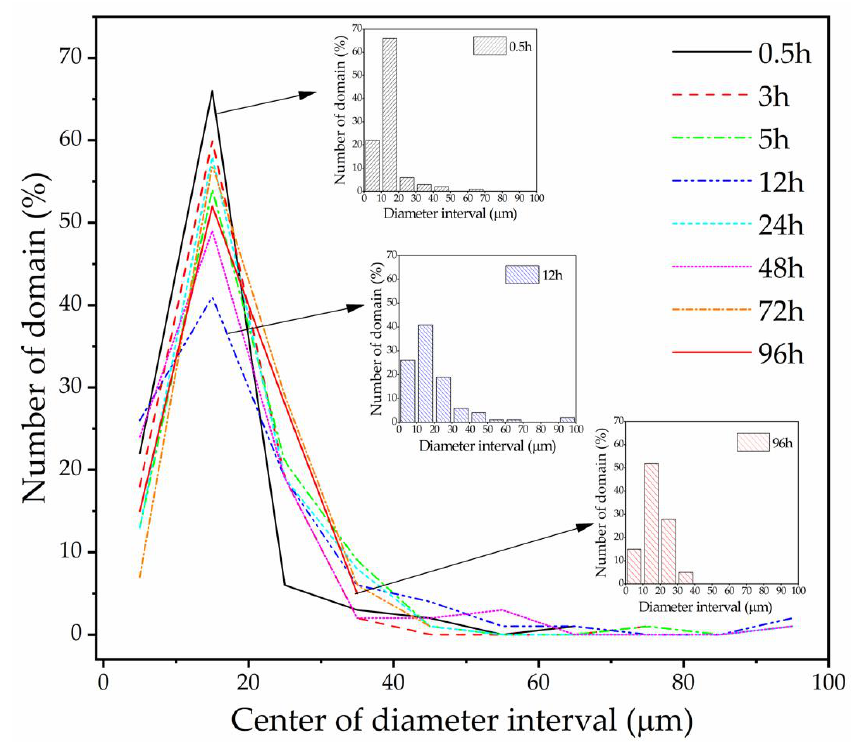
Figure 7. Diameter distribution of asphalt particles for different curing times.